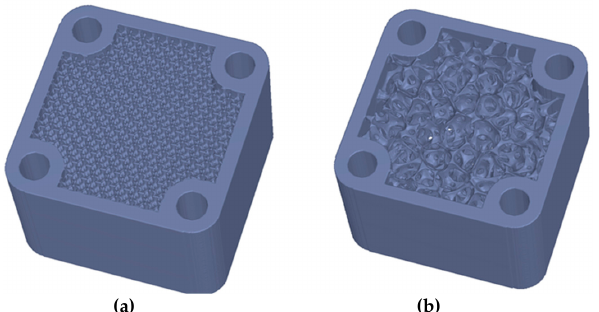
Figure 6. Examples of porous structures. ( a ) A regular structure within the component geometry. ( b ) A foam-like structure based on voronoi diagrams is depicted.